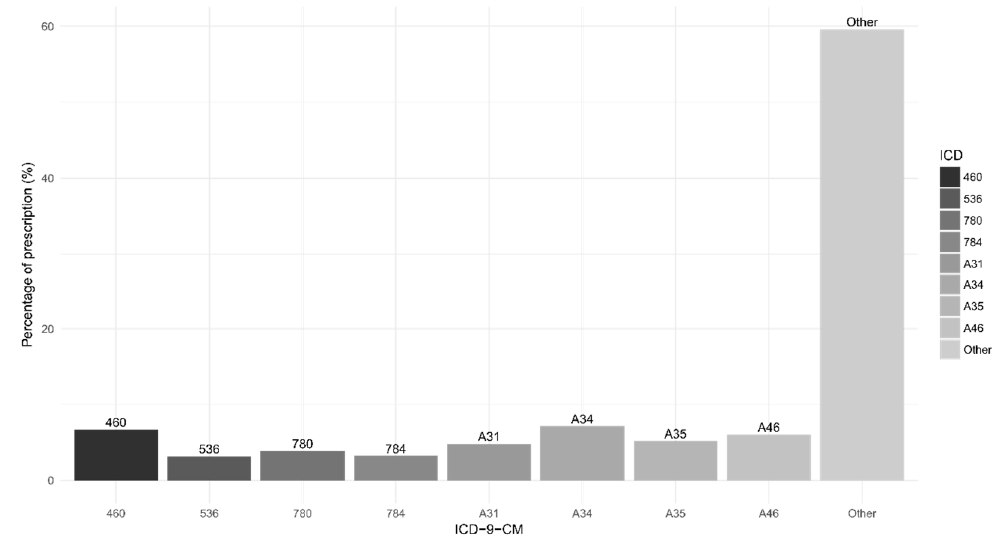
Figure 2. Main diagnosis for prescription of talcum powder.